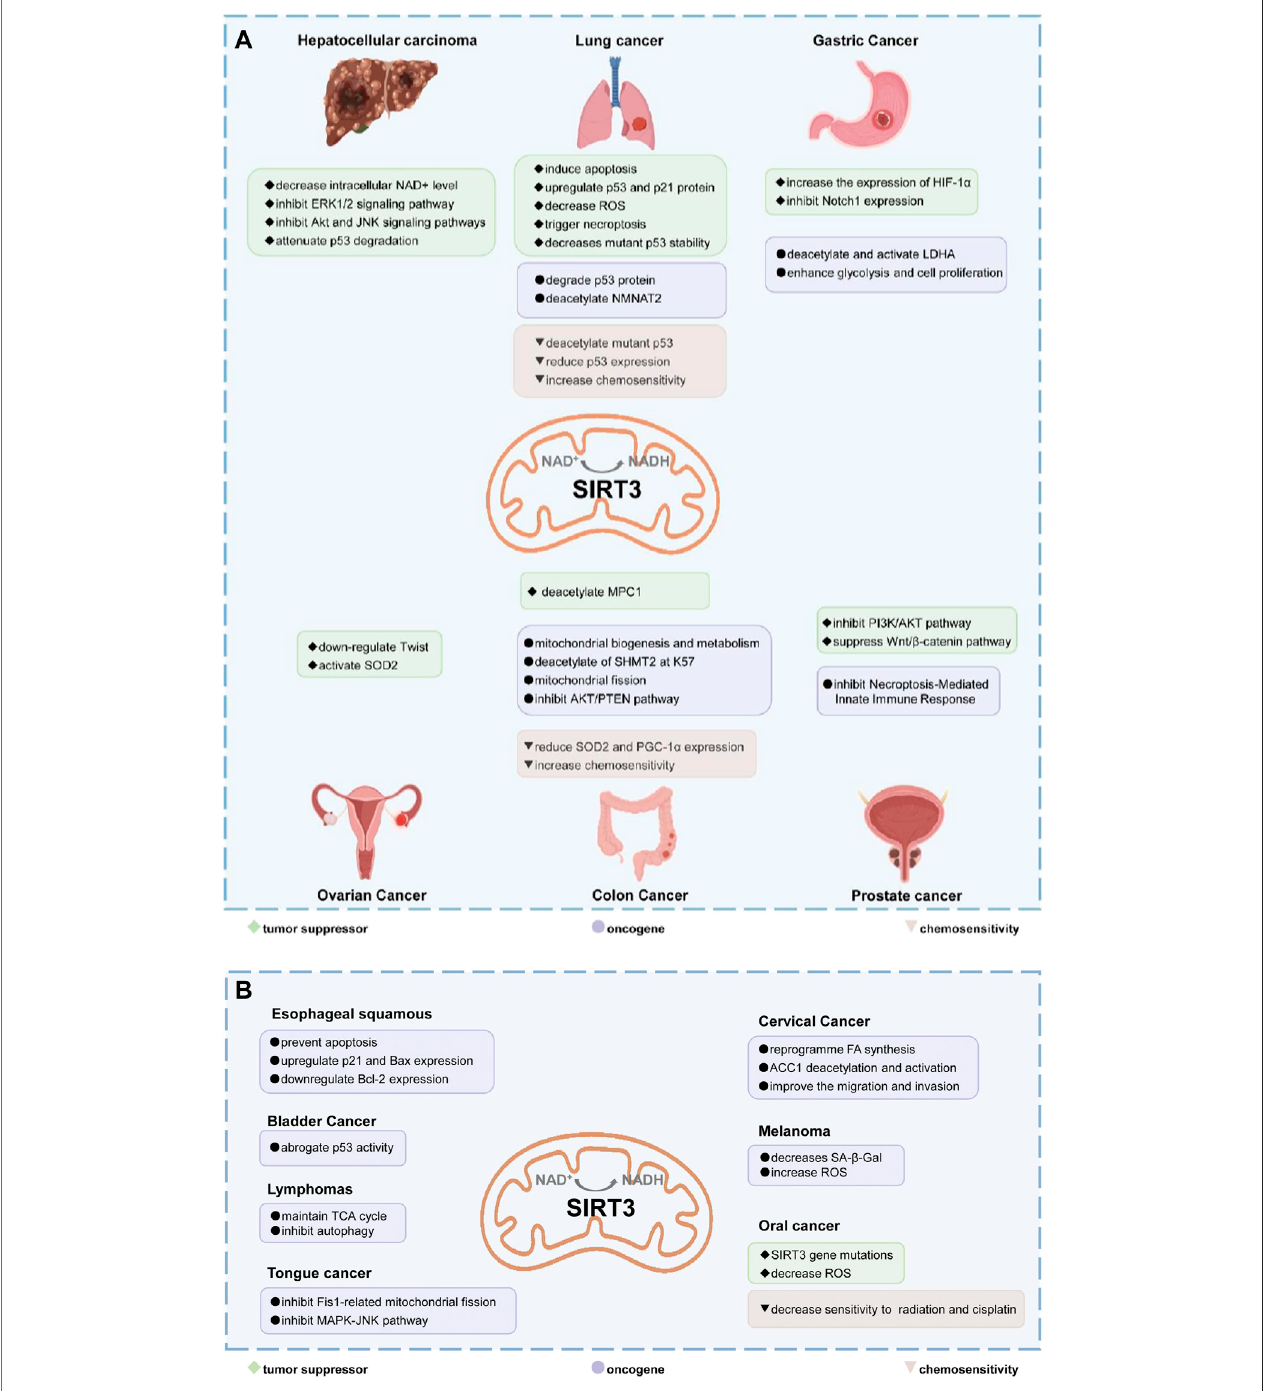
FIGURE5| ThedualroleofSIRT3indifferentcancers. (A,B) Inmostcancers,SIRT3playsatumorsuppressor role.SIRT3 canmaintainthestability ofthegenome andinhibitcarcinogenesis.SIRT3inhibitstheWarburgeffectincancertoinhibittumordevelopment.Inaddition,SIRT3caninhibittumorcellproliferationandmetastasis, andinduceapoptosisandautophagy.However,insomecancers,suchaslungcancer,gastriccancer,coloncancer,prostatecancer,andoralcancer,SIRT3actsasan oncogene by promoting proliferation and metastasis through deacetylation of speci fi c substrates. Text in green with diamond bullets indicates SIRT3 is a tumor suppressorinthosecancers.ThepurpletextwiththecircularbulletsindicatesthatSIRT3isanoncogeneinthosecancers.Thebrowntextwithtriangularbulletsindicates that SIRT3 can increase sensitivity to chemoresistance in those